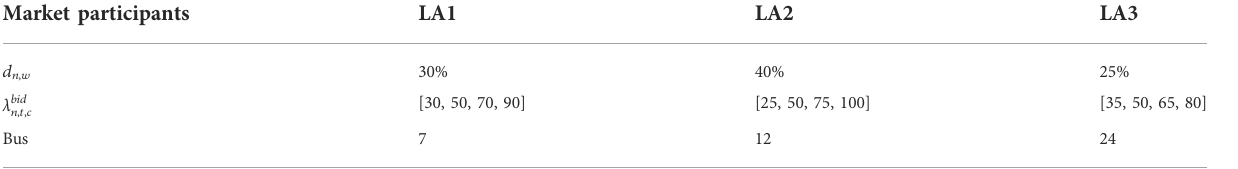
TABLE A1 Parameter settings of load aggregators.